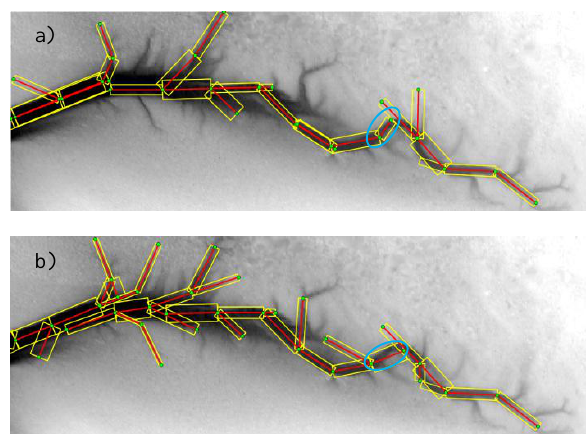
Figure 11. Results for real data of a tidal channel network using (a) all prior terms and (b) by excluding the prior term for the flow direction ( p f = 0).